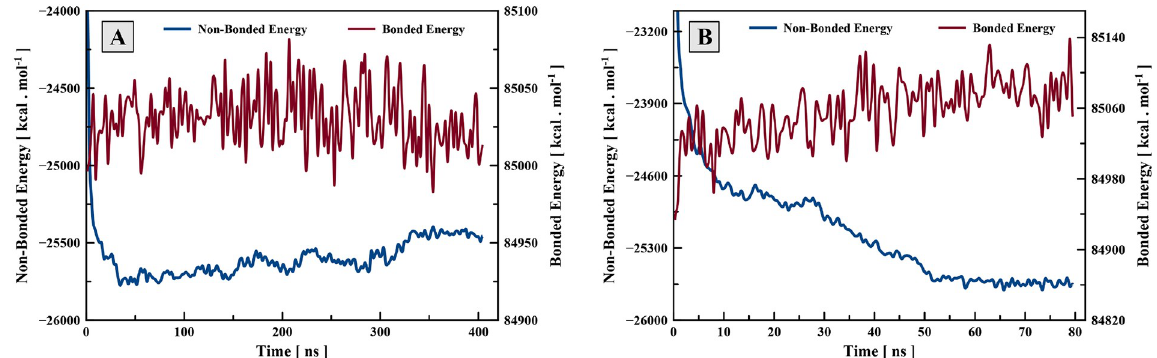
Fig 8. Bonded and non-bonded potential energies of the system of 1000 CG lipid molecules during the simulation. (A) System at 18 wt% water content during formation of the inverted hexagonal structure; (B) System at 32 wt% water content during formation of the bilayer